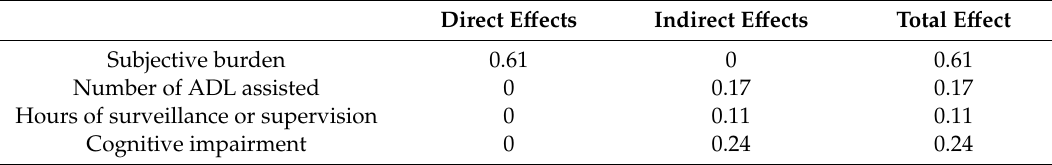
Table 3. Standardized direct, indirect, and total e ff ects of variables on anxiety in the final model. Direct E ff ects Subjective